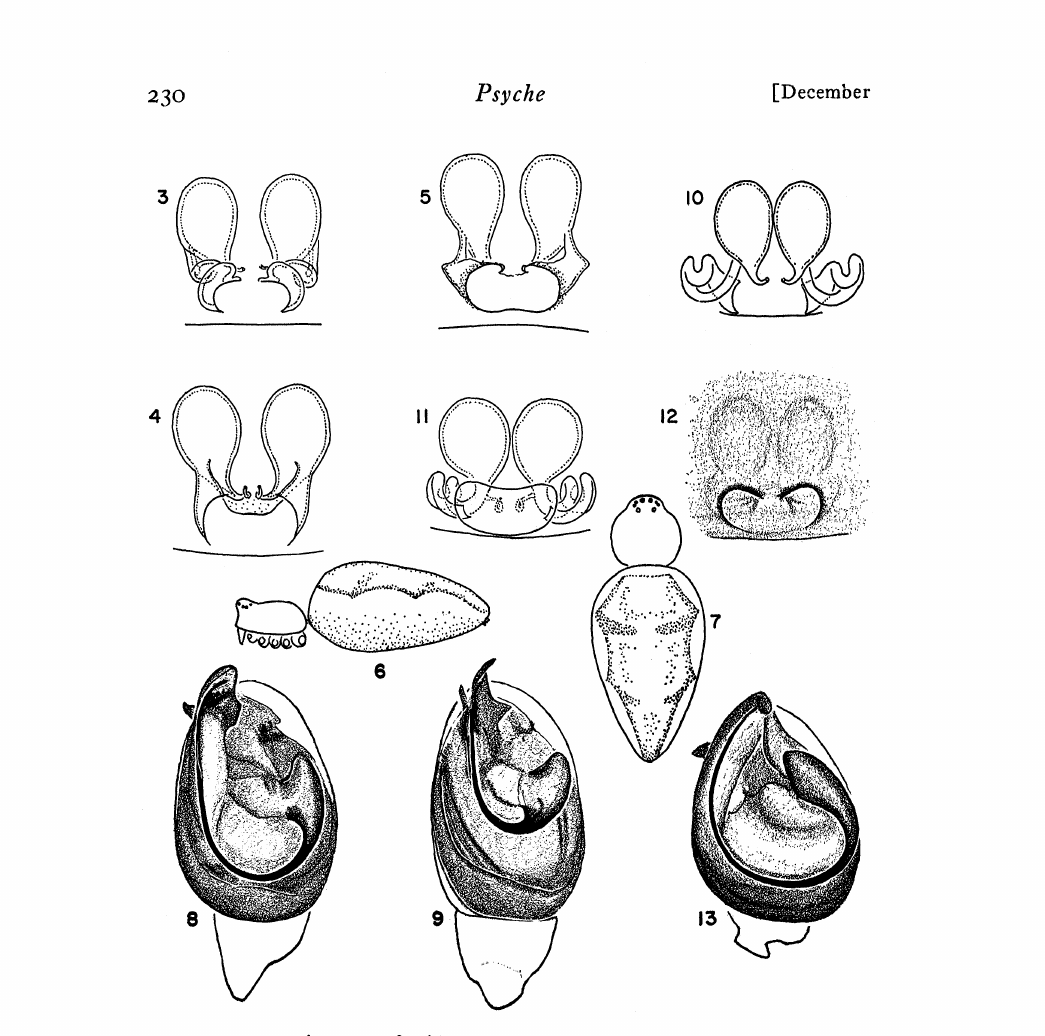
Figs. 3-9. Spintharus fla,idus Hentz. 3-5. Epigynum cleared. 3. (Wash- ington, D. C.). 4. (Peru). 5. (Bel6m, Brazil). 6, 7. Female, without legs. 8, 9. Left palpus. 8. (Washington, D. C.).. 9. (Panama). Figs. 10-13.. 8. gracilis Keyserling. 10. Female genitalia, dorsal view. 11. Epigynum, cleared. 12. Epigynum. 13.